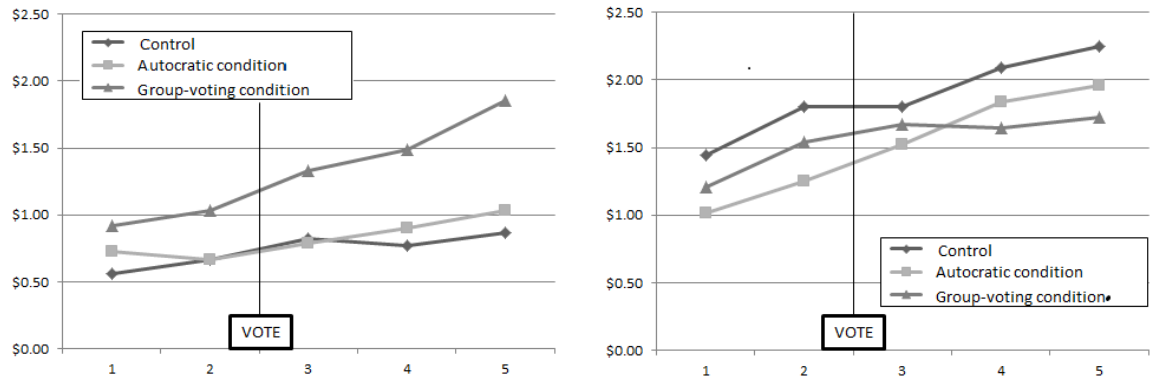
Figure 4. Evolution of the individual production of cyberloafers (left panel) and non-loafers (right panel) across periods and